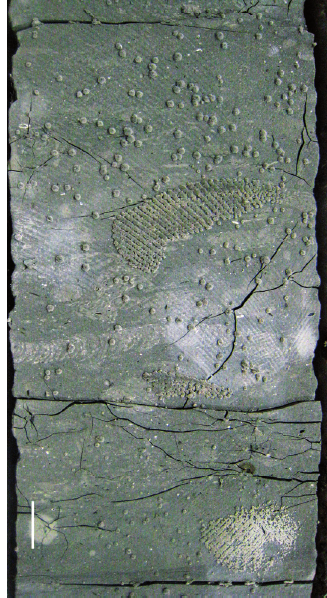
Figure 1. An example of contaminating microbial colonies growing on the core surface after long-term storage (ID: 190 -1174B- 63R-3W). Bar indicates 1